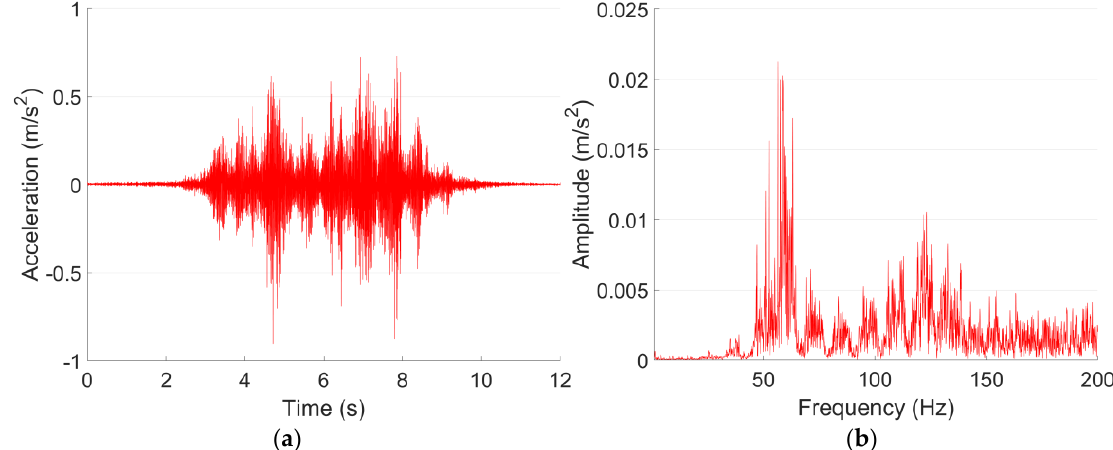
Figure 4. Typical tunnel wall acceleration responses in time ( a ) and frequency ( b ) domain in Line B.